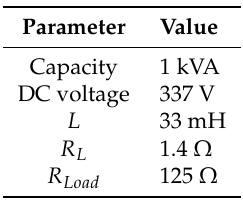
Figure 15. Snapshot of the experimental set up. Table 1. Experiment